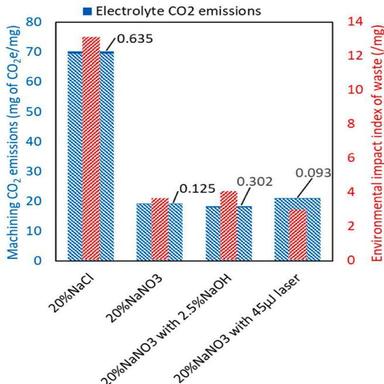
Environmental impact analysis for machining NbC–Ni cermet with ECM in different electrolytes and LECM in 20% NaNO3.